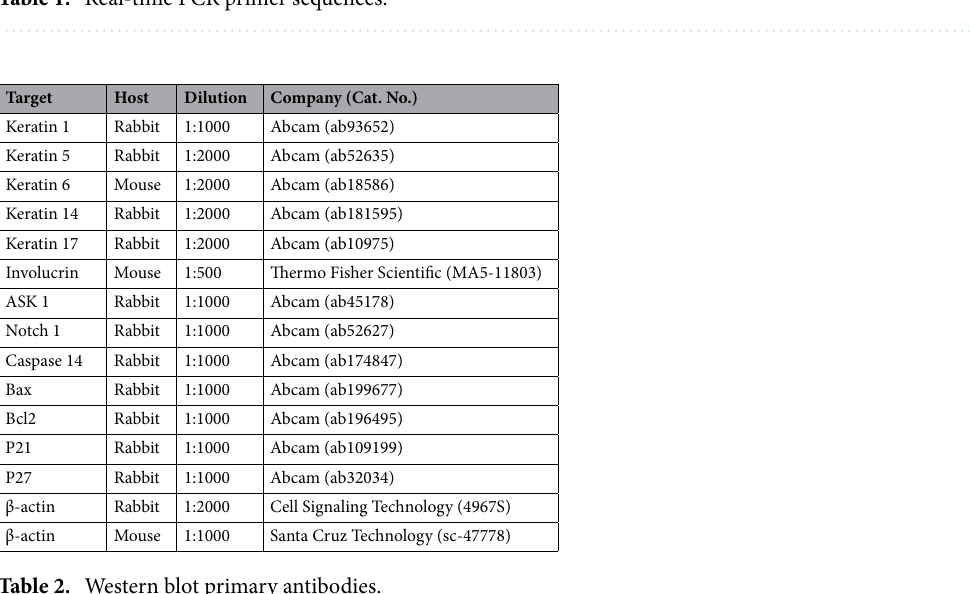
Table 1. Real-time PCR primer sequences.